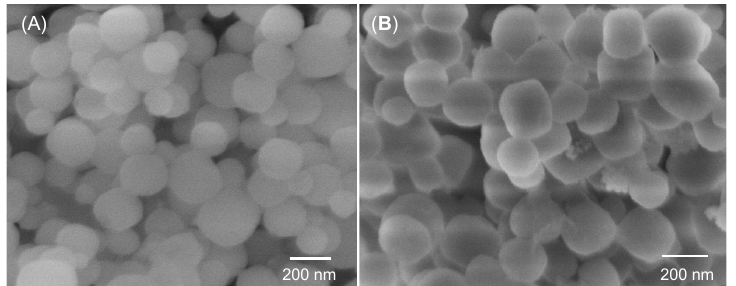
Figure 2. The morphology and mesostructure of nanoparticles: ( A ) SEM image of MSNs and ( B ) SEM image of PDEAEMA–MSNs.